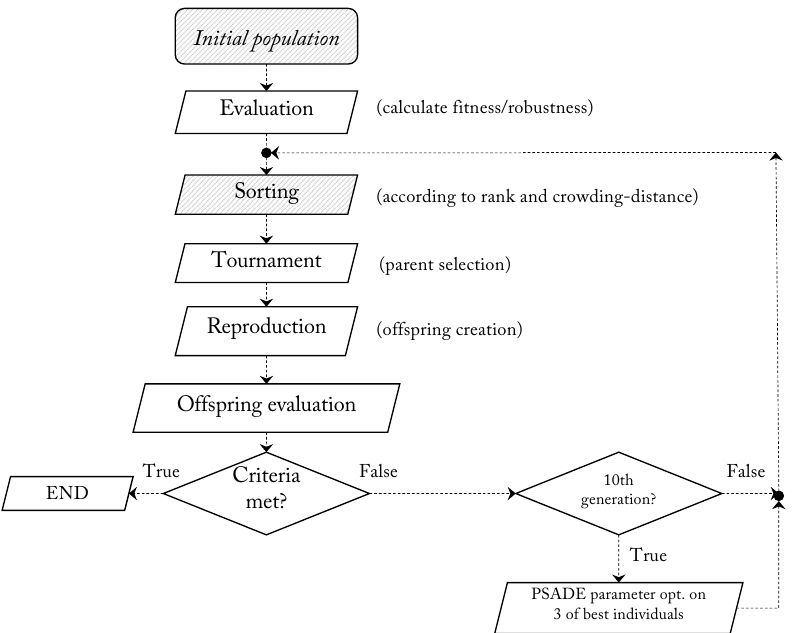
Figure 4. The flowchart of the evolutionary algorithm. Every tenth generation, a full parameter optimization is triggered on best individuals.